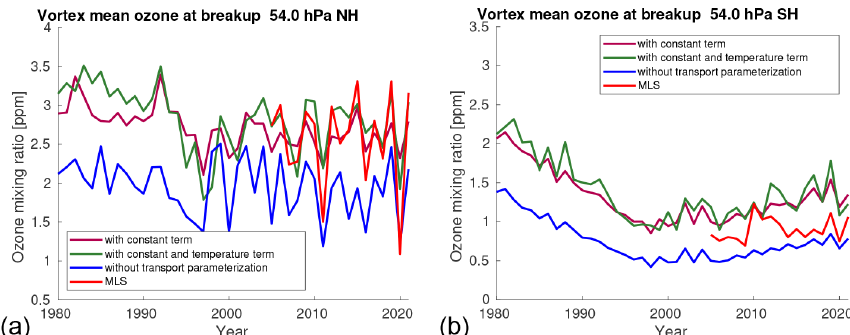
Figure 6. Vortex-averaged ozone at 54hPa simulated by the stand-alone Polar SWIFT model for the date of vortex breakup (see Table 3, but note that in 2011, we use 25 March in the plot due to an instrument failure of the MLS instrument) in the Northern Hemisphere (a) and Southern Hemisphere (b) for different years. Ozone mixing ratios simulated without the transport parameterization (blue), ozone mixing ratios simulated with only the constant-change term of the transport parameterization (brown), ozone mixing ratios simulated with the full transport parameterization with the constant-change term and temperature-dependent term (green), and corresponding measurements of ozone from the MLS instrument (red).